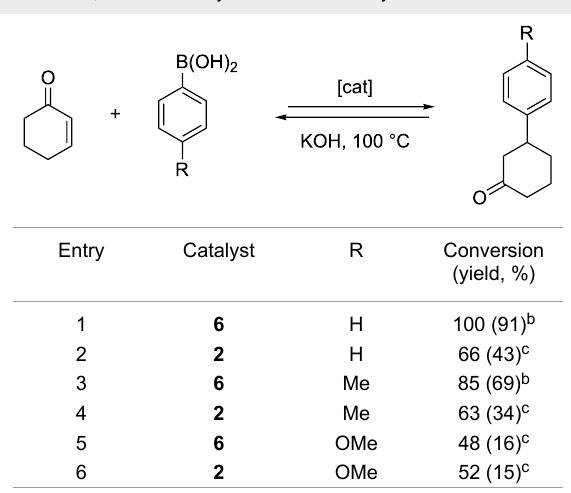
Table 1: 1,4-Addition of arylboronic acids to 2-cyclohex-1-one.